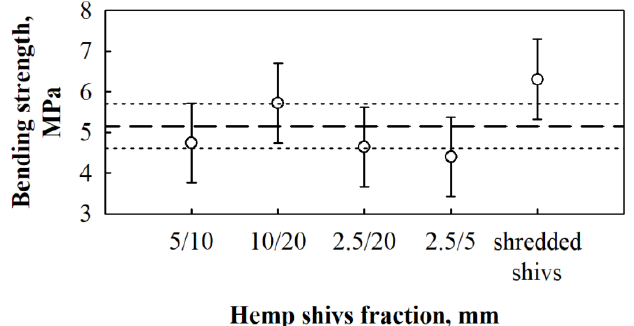
Figure 8. Impact of different HS fractions and 10 wt.% of CS binder on bending strength of BcB. (- - - - -)—the average values of the whole bending strength results; ( ········· )—confidence interval with 95% reliability.